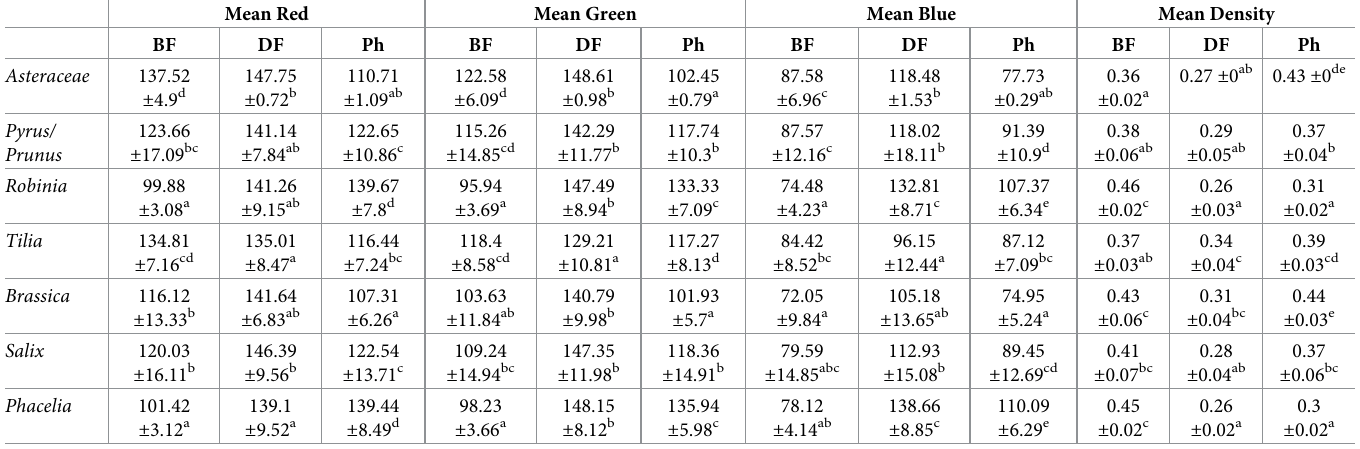
Table 9. RGB colour descriptor of pollen grains. Mean